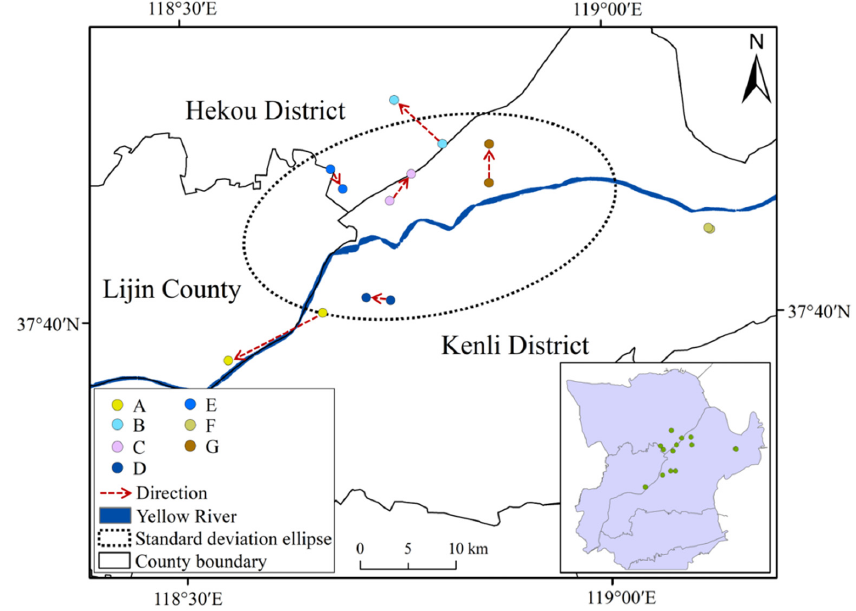
Figure 10. Migration directions of gravity centers of different wetland types in the YRD from 2015 to 2021. Table 9. Type codes for wetlands. Table 9. Type codes for wetlands.